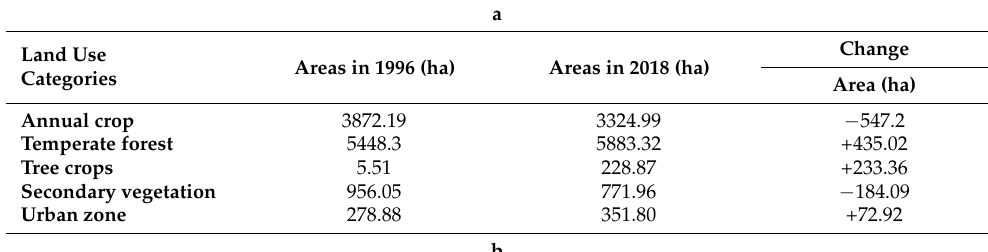
Table 2. ( a ) The area of land use and land cover changes from 1996–2018. ( b ) Land use transition from 1996 to